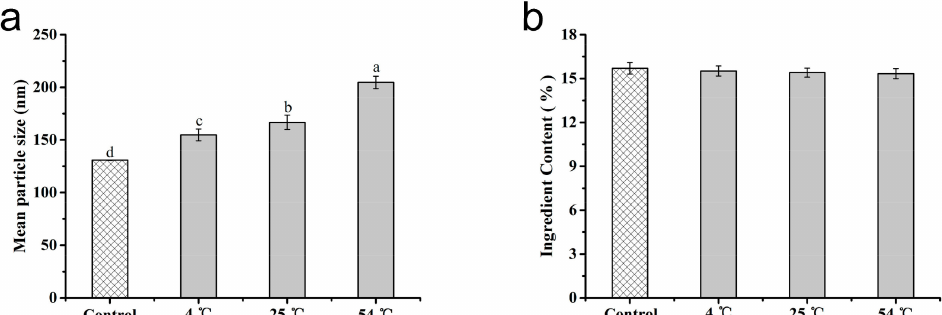
Figure 9. Storage stability of the MS1 microsphere for 14 d: ( a ) hydrated mean particle size; ( b ) active ingredient content. For hydrated mean particle sizes and ingredient contents, different lowercase letters indicated statistically significant differences (one-way ANOVA, Student–Newman–Keuls (SNK) test, p <